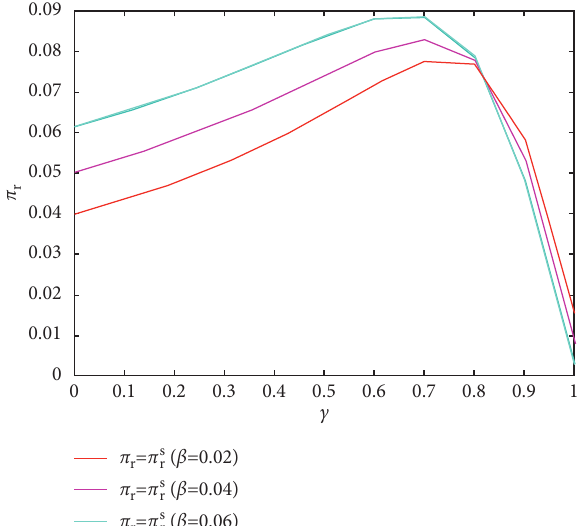
Figure 6: Effect of c on the profit of the